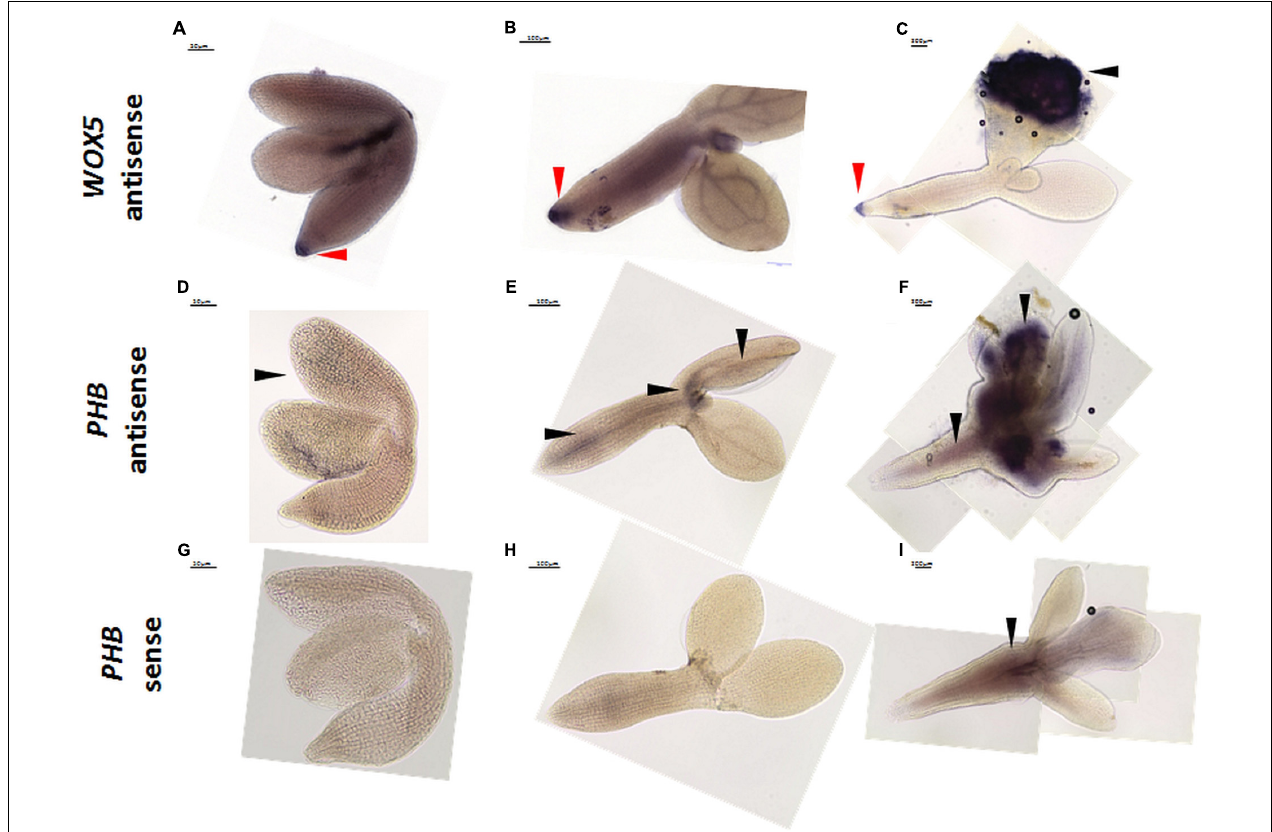
FIGURE 7 | Whole mount in situ hybridization of WOX5 (A–C) and PHB (D–I) in the explants undergoing SE induction at 0th day (A,D,G) , 5th day (B,E,H) , and 10th day (C,F,I) . The sense probes PHB (G–I) and WOX5 (not shown) were used as the controls. Arrow heads indicate the detected signal; red arrow heads indicate the detected signal in RAM.